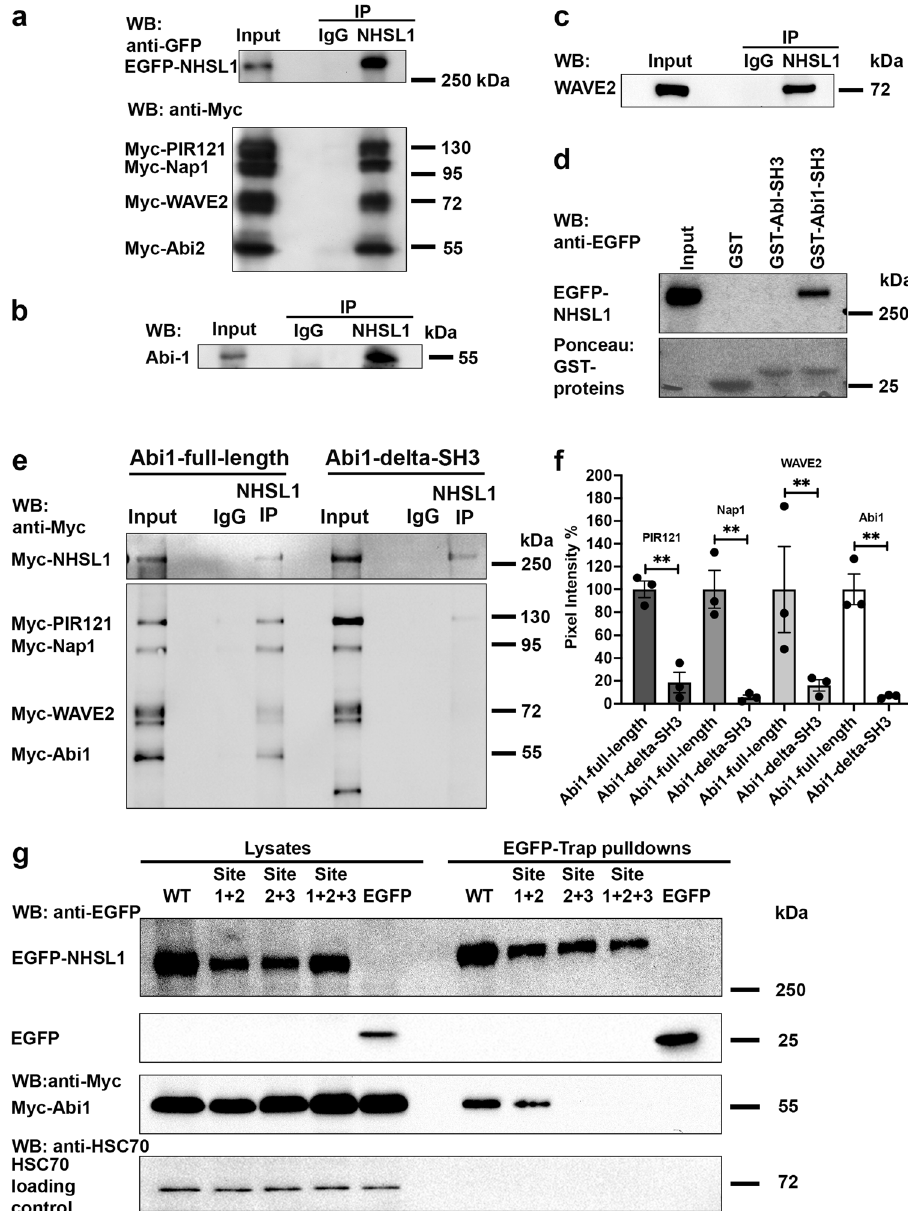
Fig. 5 NHSL1 interacts with Abi and the Scar/WAVE complex. a The Scar/WAVE complex co-immunoprecipitates with NHSL1. HEK cells were transfected with EGFP-NHSL1, and Myc-Pir121, -Nap-1, -WAVE2, -Abi2. NHSL1 was immunoprecipitated (pAb 4457) from lysates and co- immunoprecipitation tested on a western blot with Myc and EGFP antibodies. (see Supplementary Fig. 9a, b for full western blots). b , c Western blot showing endogenous NHSL1 pulled down with polyclonal NHSL1 (4457) antibody followed by western blotting with b Abi1 and c Scar/WAVE2 antibodies detecting endogenous co-immunoprecipitation of these proteins in MCF10A (Abi1) and B16-F1 (Scar/WAVE2) cell lysates. Immunoprecipitation using non- immune rabbit IgG served as a negative control. d GST-pulldowns using puri fi ed Glutathione-sepharose coupled GST-fusion proteins of Abi1 and c-Abl-SH3 domains or GST alone from HEK cell lysates that were transfected with EGFP-NHSL1. Following GST-pulldown EGFP-NHSL1 was detected in a western blot with anti-EGFP antibodies. Ponceau staining of membrane reveals GST or GST-tagged Abi- or Abl-SH3 domains used. e Western blot showing immunoprecipitation using NHSL1 polyclonal (4457) antibody or non-immune rabbit IgG control from HEK cell lysates expressing Myc-NHSL1 and all Myc- tagged components of the Scar/WAVE complex, including Myc-Abi1-full-length ( e , left), Myc- Abi1-delta-SH3 ( e , right). The western blot shows co- immunoprecipitation between NHSL1 and all components of the Scar/WAVE complex only when the Abi SH3 domain is present (Myc-HSPC300 is not shown). a – e Representative blots from three independent biological experiments. f Quanti fi cation of band intensity from chemiluminescence from e imaged with a CCD camera. Co-immunoprecipitation is reduced by >80%. Bars indicate mean ± SEM (error bars); n = 3 independent biological experiments; one-way ANOVA: P = 0.0002; F (7,16) = 8.855; Sidak ’ s multiple comparisons tests: PIR121 ** p = 0.0093; Nap1 ** P = 0.0028; WAVE2 ** P = 0.0074; Abi1 ** P = 0.0030. g HEK cells were transfected with EGFP-tagged NHSL1 or NHSL1-SH3 binding mutants or EGFP only as negative control and Myc-Abi1. After GFP-trap pulldown of wild-type (WT) NHSL1 or different NHSL1-SH3 binding mutants, co-precipitation was detected in a western blot with Myc antibody. Representative blots from fi ve independent biological experiments. Source data are provided as a Source Data fi le.